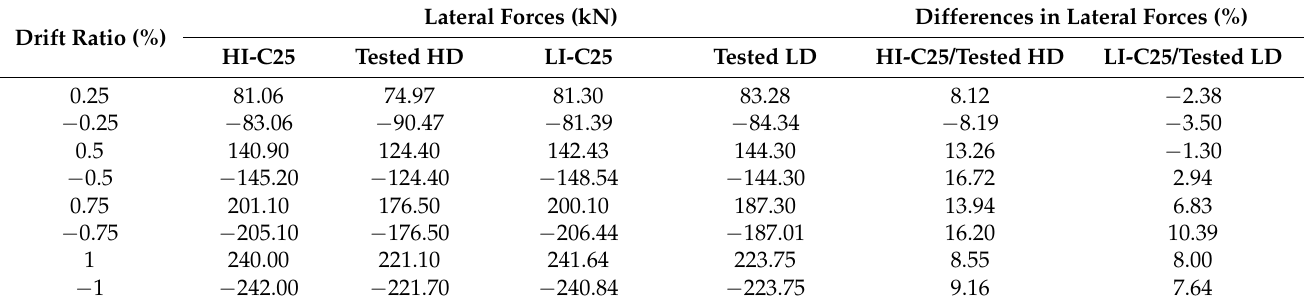
Table 6. Maximum applied lateral forces of tested frames, HI-C25 and LI-C25.